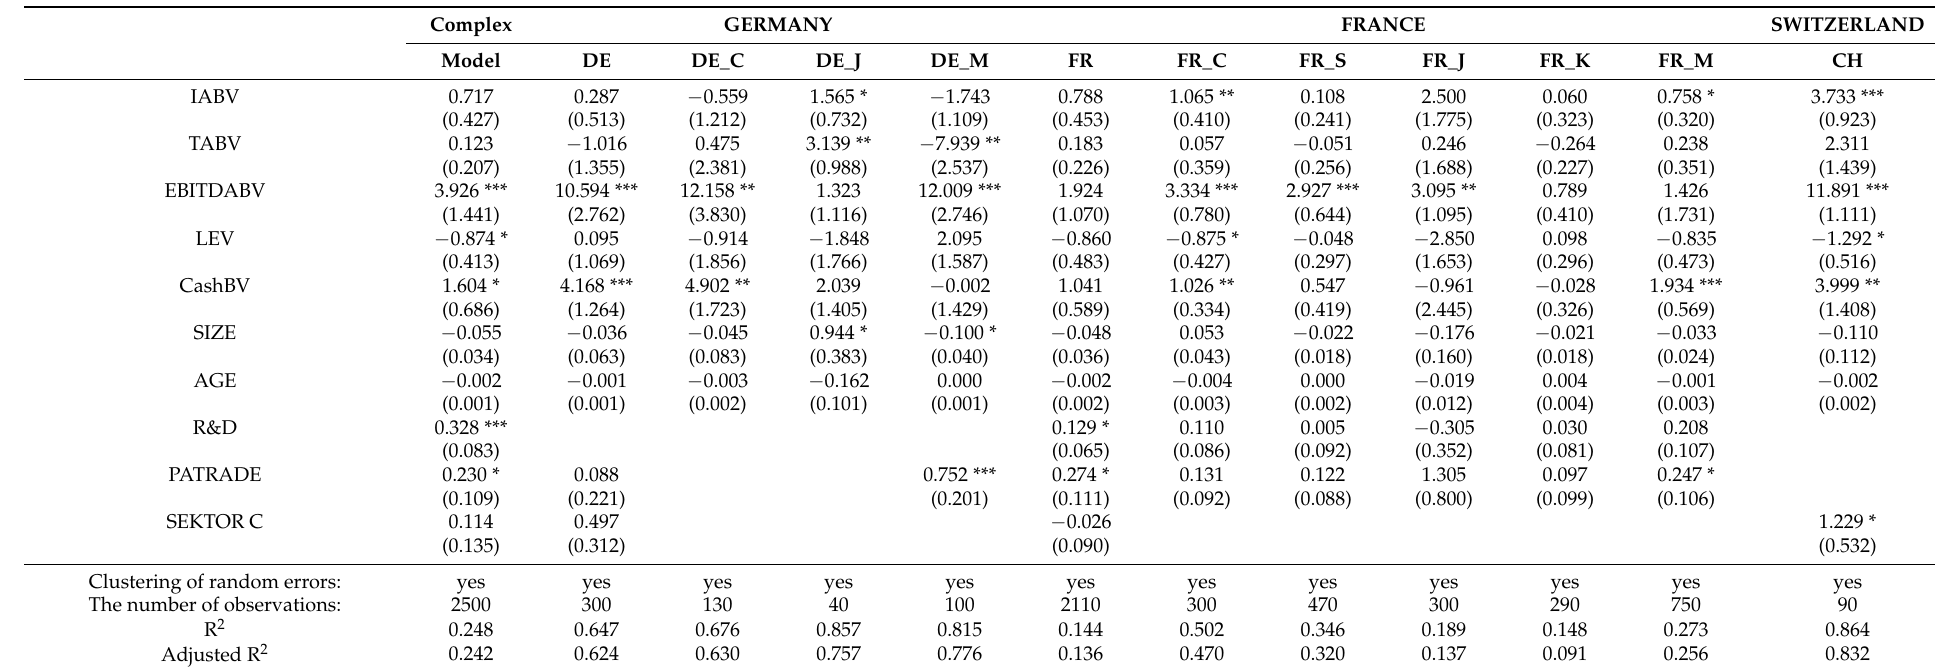
Table 3. Panel regression results of the impact of particular variables on market value in the selected